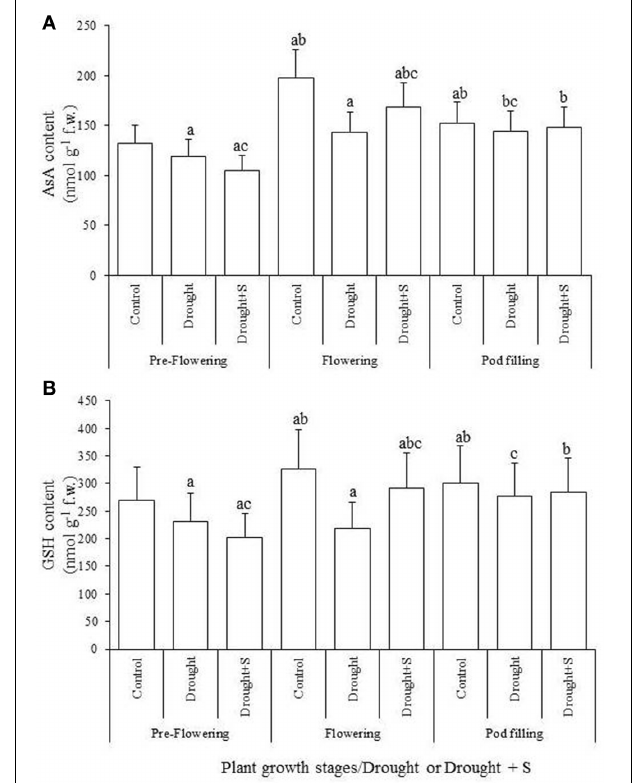
FIGURE 2 | The reduced ascorbate (AsA) (A) and reduced glutathione (GSH) (B) contents (nmol g − 1 fresh weight) in the mungbean ( Vigna radiata ) leaf as influenced by drought stress and sulfur (S) application (mg kg − 1 soil) at pre-flowering, flowering, and pod-filling stages of plant growth. Values are the means of five replicates ± standard deviation. Significant differences within same growth stage are: a vs. Control; b vs. Drought (pre-flowering); c vs. Drought (flowering); and d vs. Drought